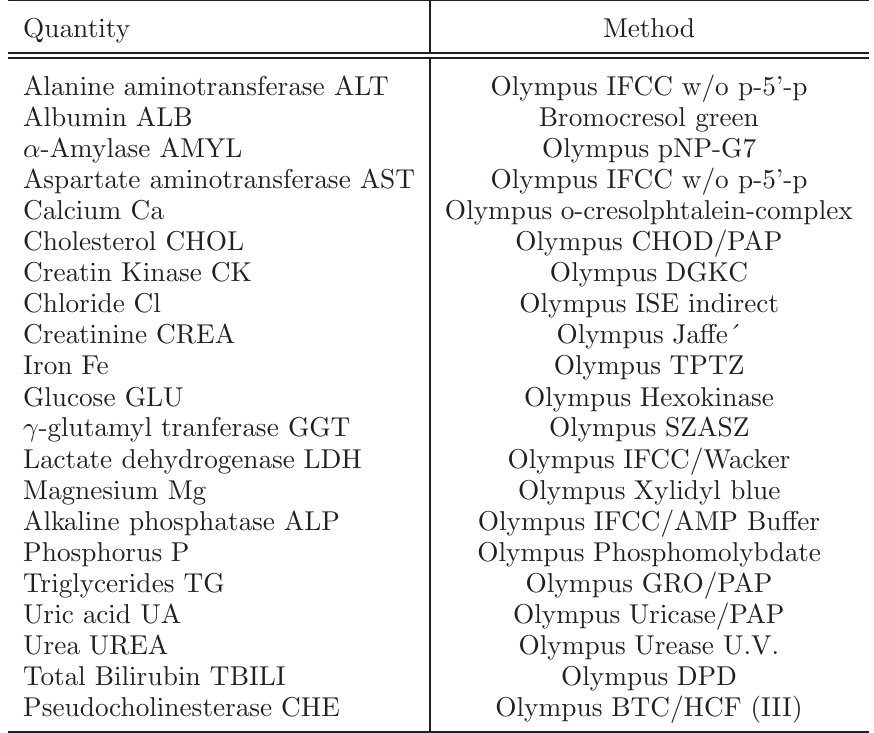
Table 1 Methods used for the determination of the different quantities (37 ◦ C)